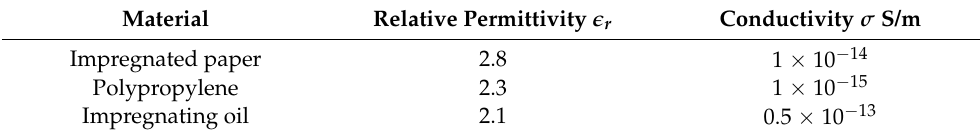
Table 1. Electrical properties.